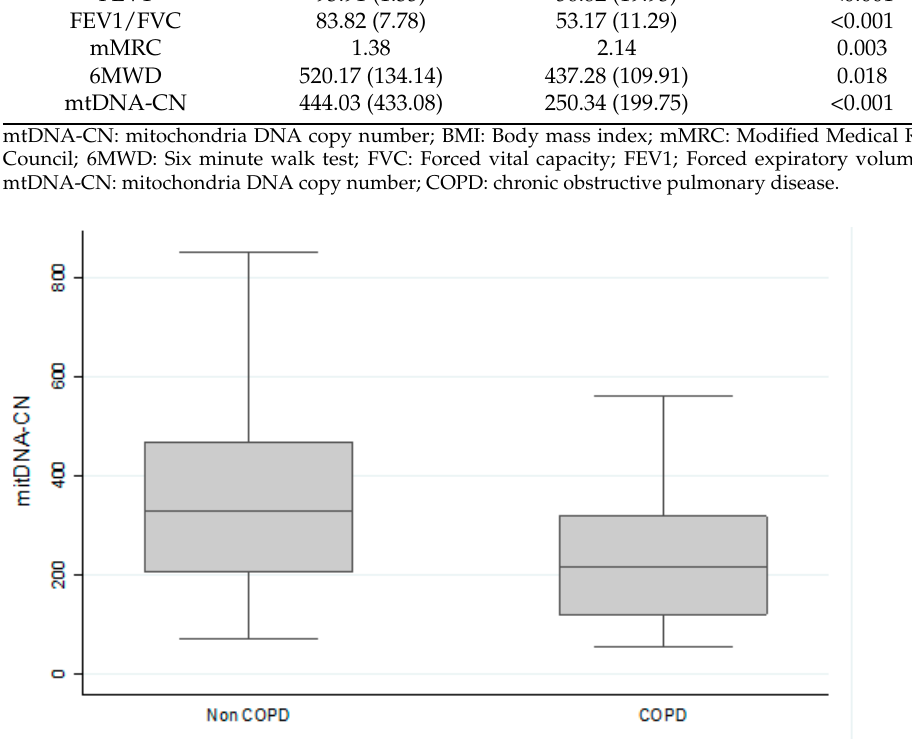
Figure 1. The patients with COPD exhibited significantly lower mitochondria DNA copy number than the individuals without did. ( p < 0.05). 3.2. Comparison of mtDNA-CN in Individual IL 13 Genotype (CC, CT, TT) in COPD and Non- For all IL13 genotypes, including CC, CT, and TT, non-COPD patients had signifi- cantly higher mtDNA-CN than COPD patients (Table 2 and Figure 2).